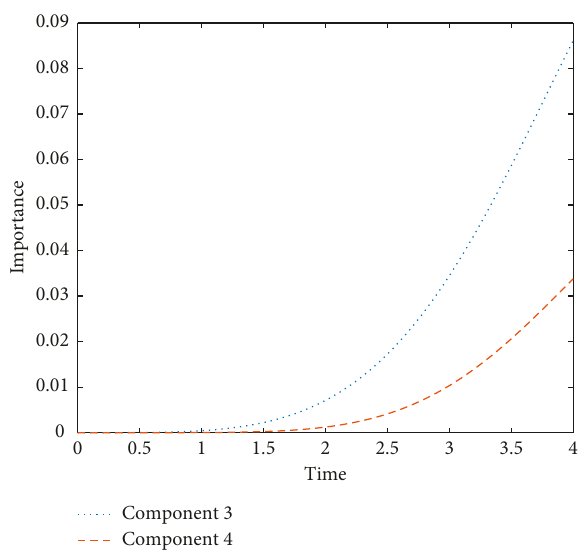
Figure 8: Importance of component 3 and component